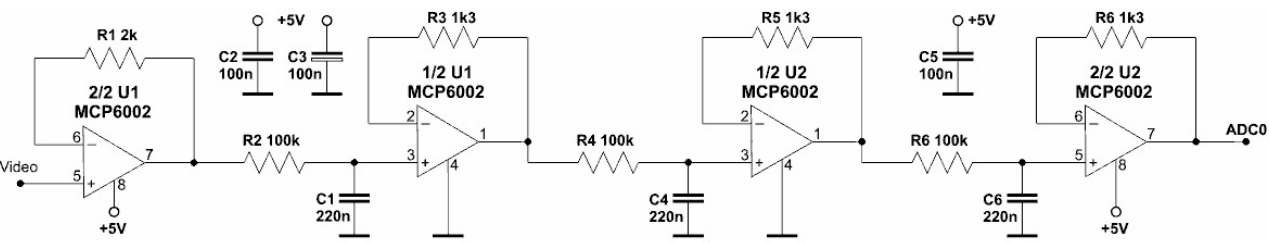
Figure 17. Low-pass filter schematic used in the measurement circuit.